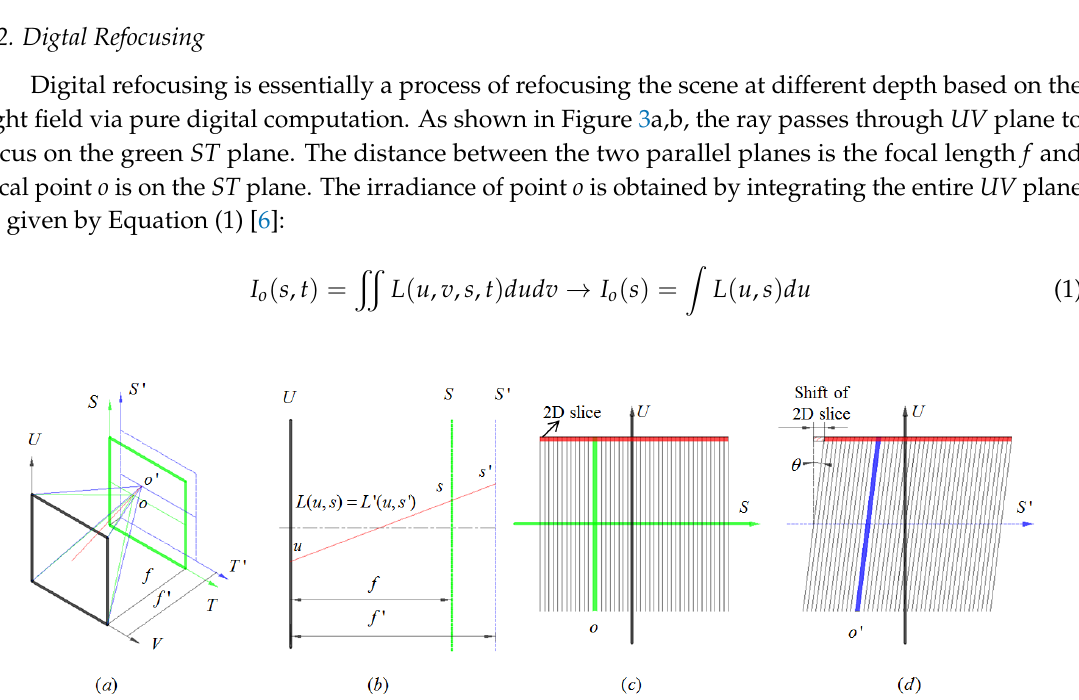
Figure 2. Two-plane parametrization of light field. ( a ) Two-plane parametrization; ( b ) two-dimensional (2D) Cartesian ray-space diagram.